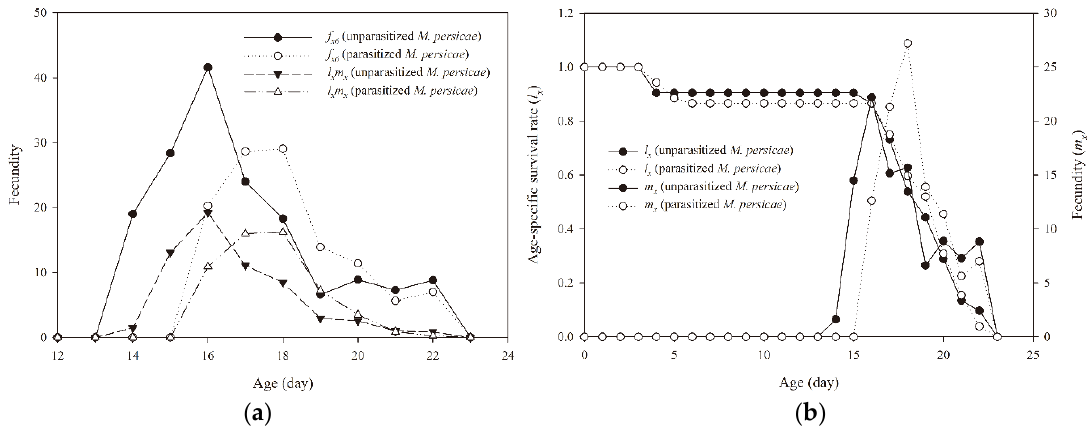
Figure 2. Female age-specific fecundity ( f x6 , ( a )), age-specific maternity ( l x m x , ( a )), age-specific survival rate ( l x , ( b )) and age-specific fecundity of the total population ( m x , ( b )) of Aphidoletes aphidimyza that fed on unparasitized and parasitized Myzus persicae by Aphidius gifuensis.